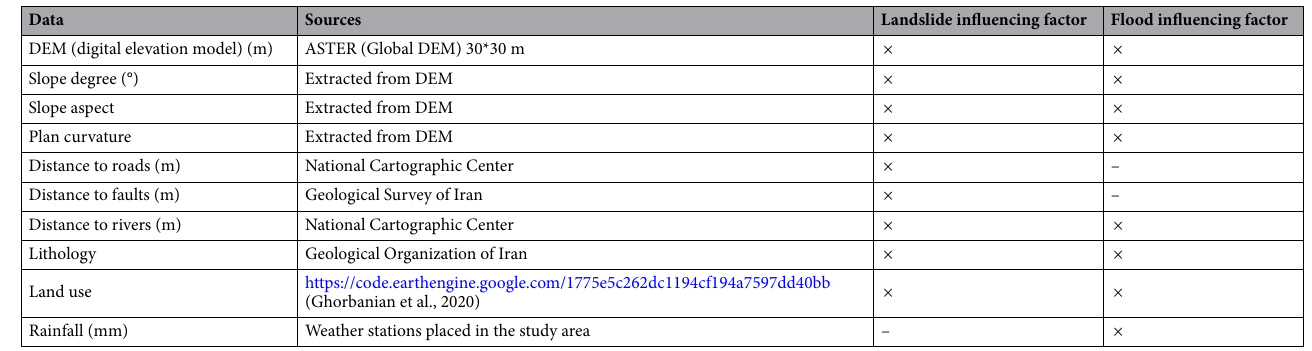
Table 5. Data and their sources used for susceptibility mapping of two hazards.